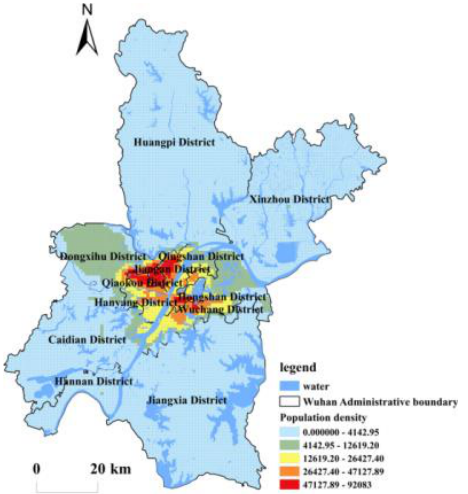
Figure.2 Distribution of population data